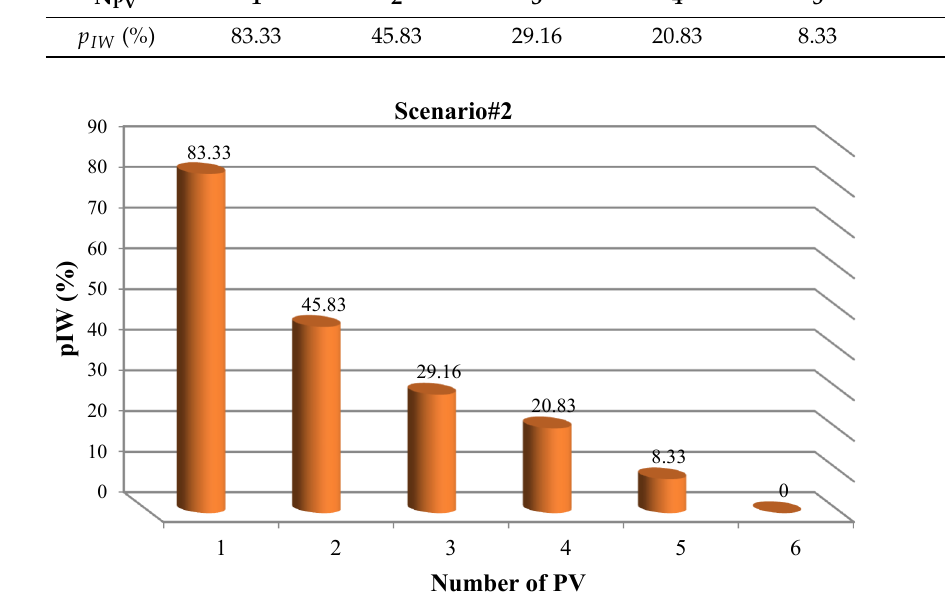
Figure 9. Changes relative to PV number in the Scenario 2. Figure 10. Changes relative to PV number in the Scenario 2.